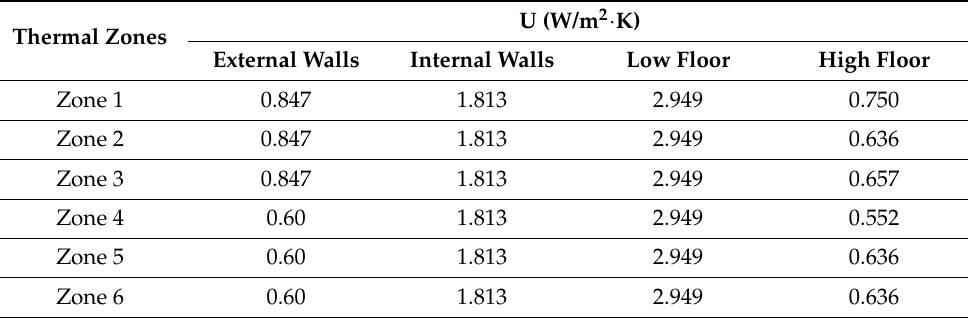
Table 4. Thermal characteristics of insulated building walls and floors according to the Moroc- can standards.